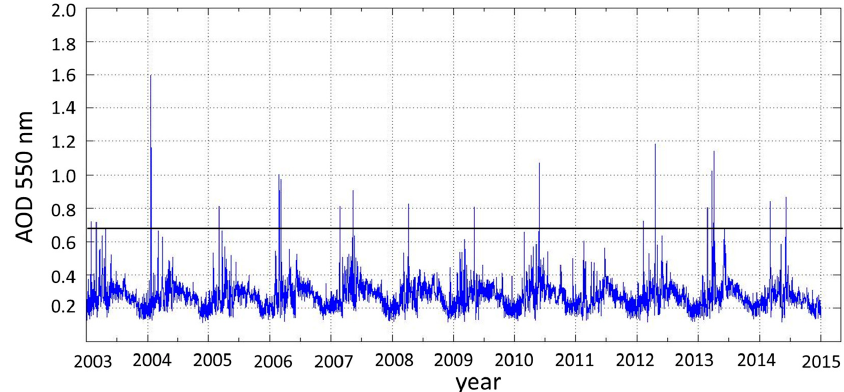
Figure 2. Time series of daily aerosol optical depth (AOD) over Egypt from 1 January 2003 to 31 December 2014 with the threshold (thick dark line) that defines the threshold of AOD of SAPEs.